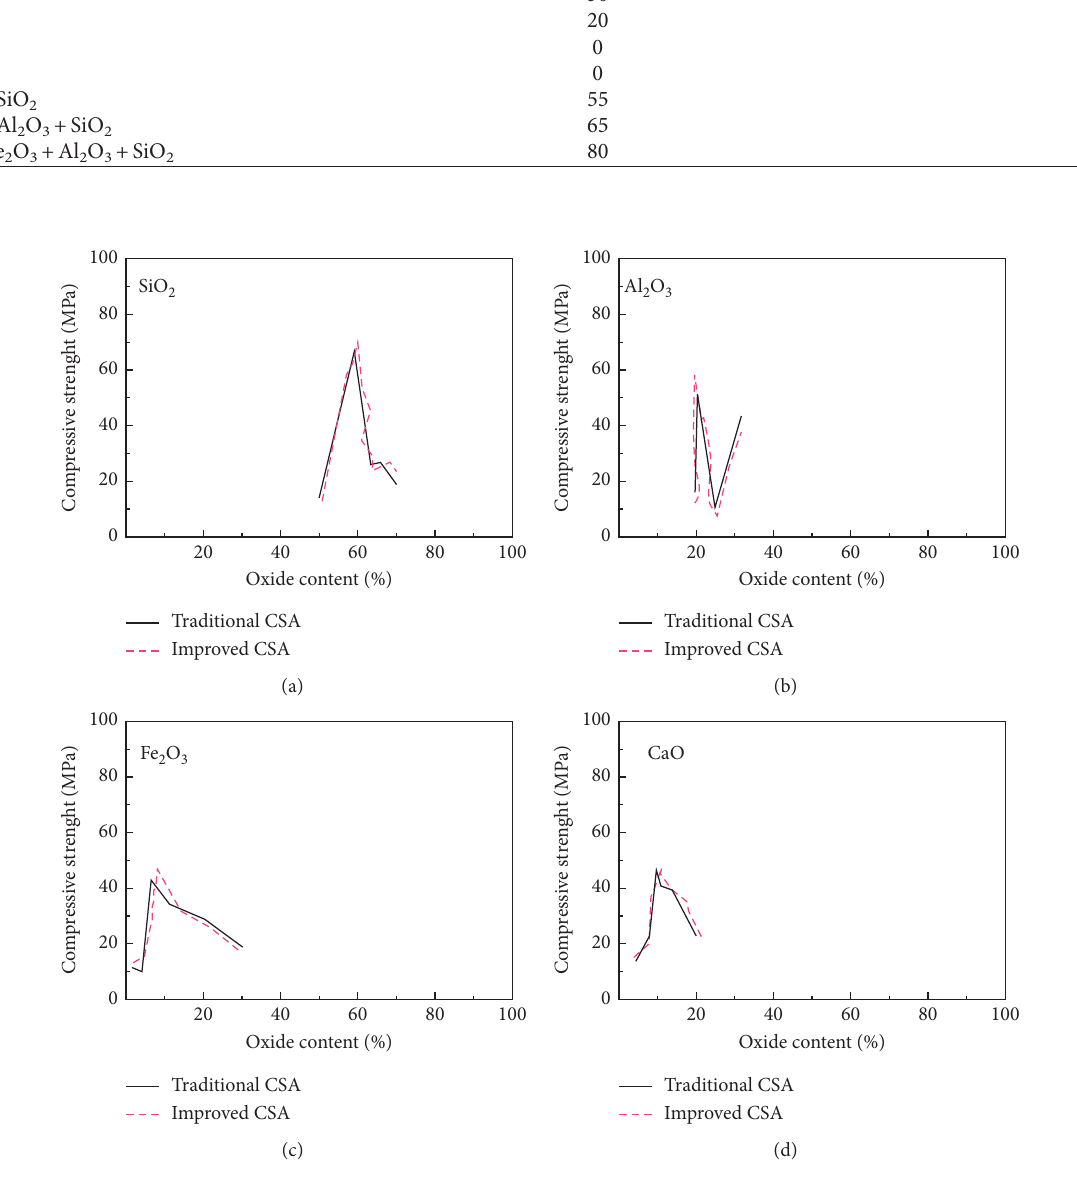
2 . (b) Compressive strength